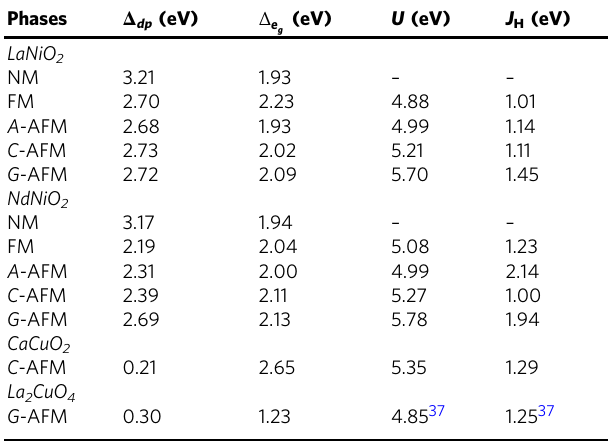
Table 2 Comparison of properties of various phases of the nickelates and cuprates. Δ dp and Δ the metallic (Ni and Cu) 3 d and O 2 p bands, and the splitting of the transition-metal ions (Ni and Cu) e g bands, respectively.